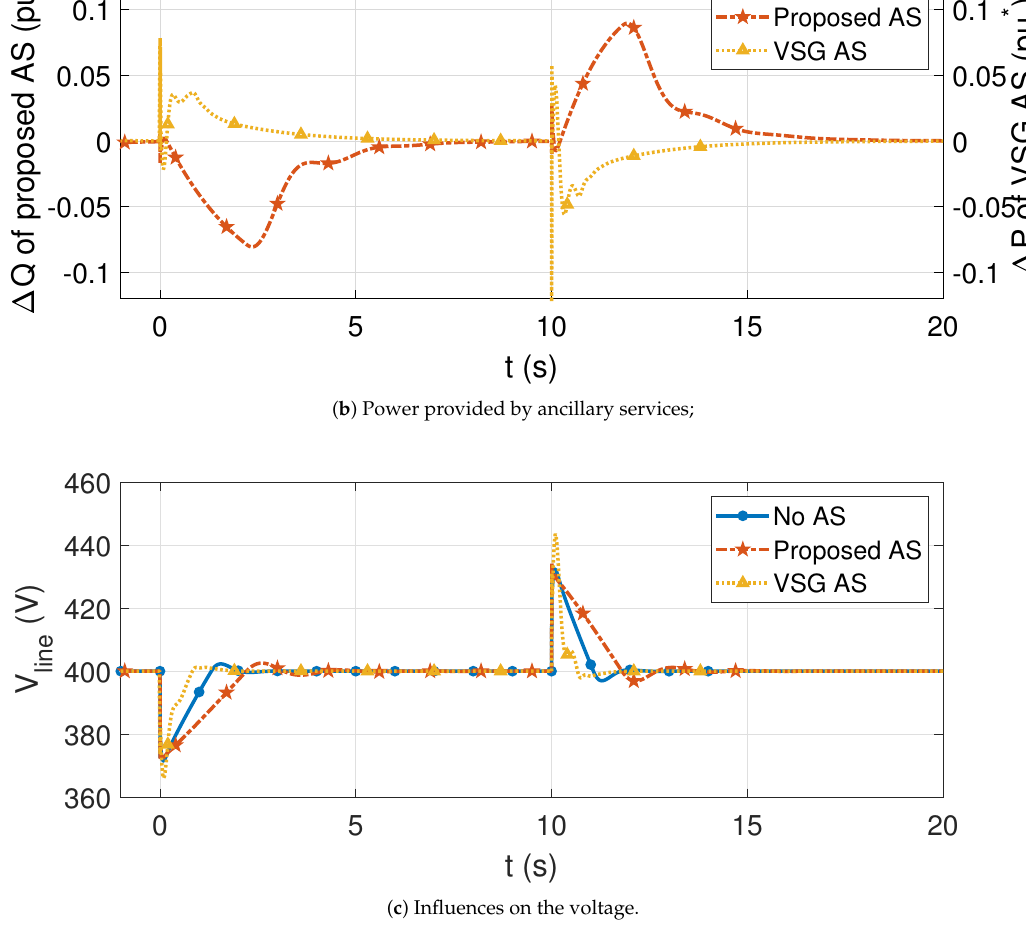
Figure 7. Offline simulation test results of the proposed ancillary service (AS) in comparison with VSG. ∗ pu values are obtained according to the base values of the synchronous generation system in Table